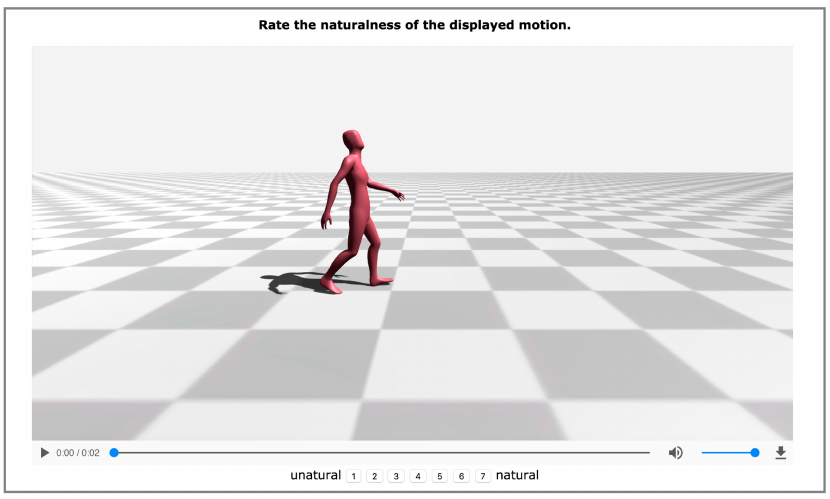
Figure 12. A screenshot from the conducted